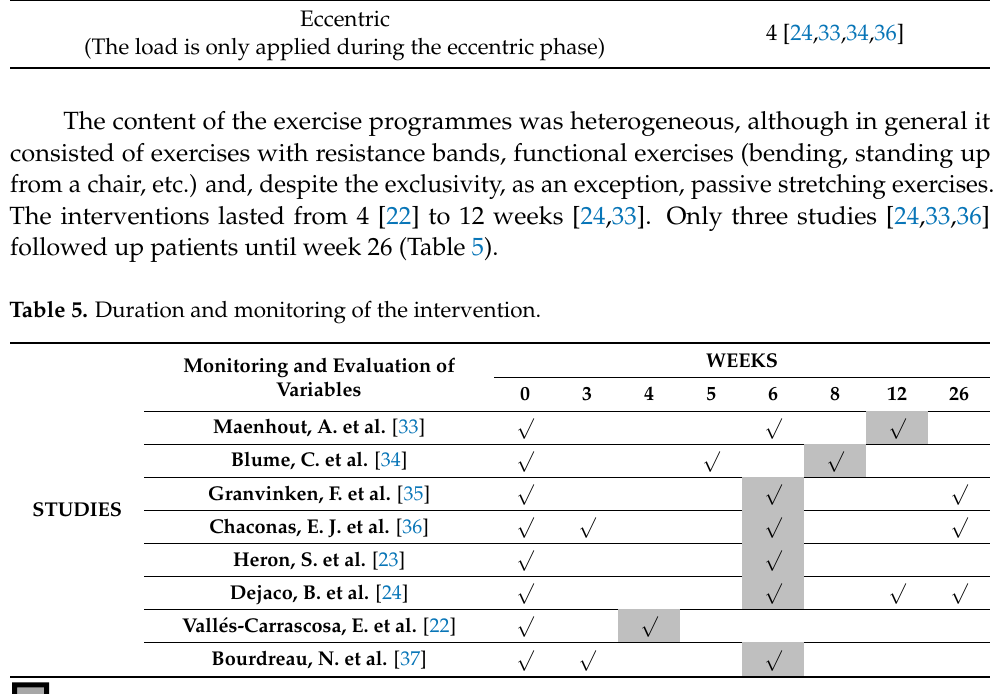
Table 6. PROMs used in selected